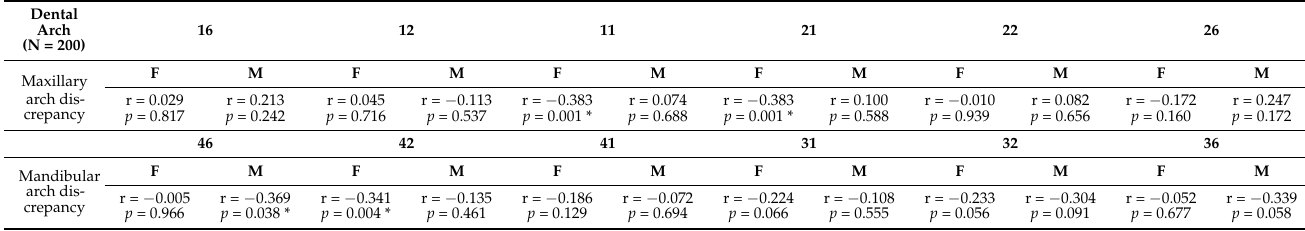
Table 11. Statistical correlations between MD teeth dimensions and arch discrepancies for female and male patients (Pearson correlation